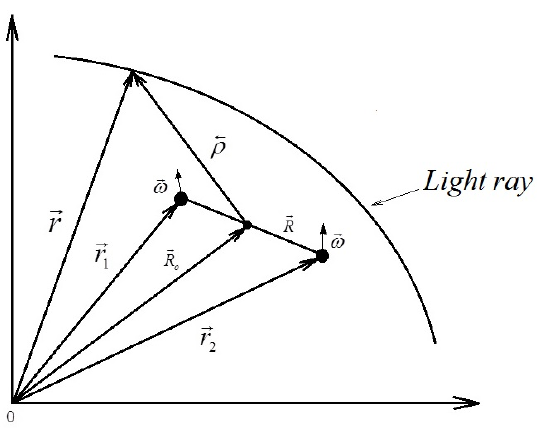
Fig. 1. Scheme of light-ray propagation in the gravitational (cid:28)eld of two rotating